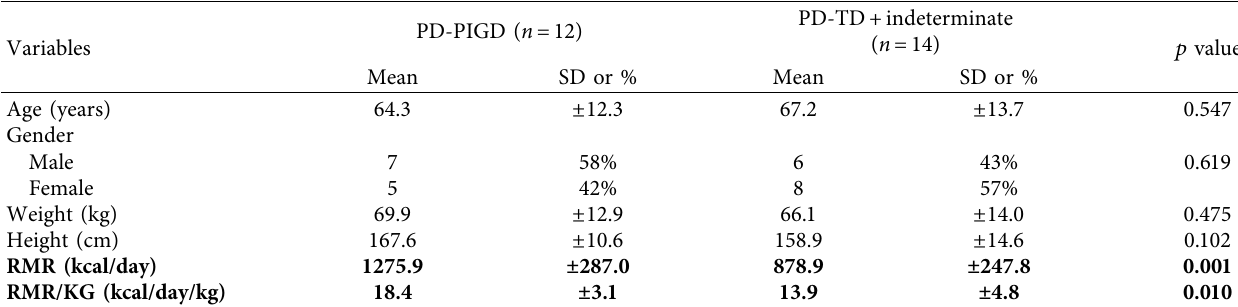
Table 4: RMR of PD-TD+ indeterminate and PD-PIGD